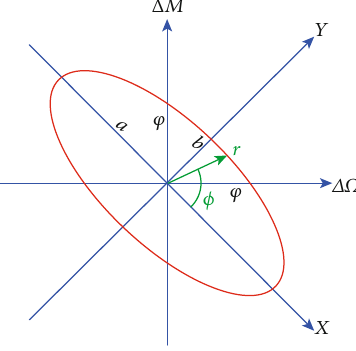
Figure 21: The best range to create crosslinks.